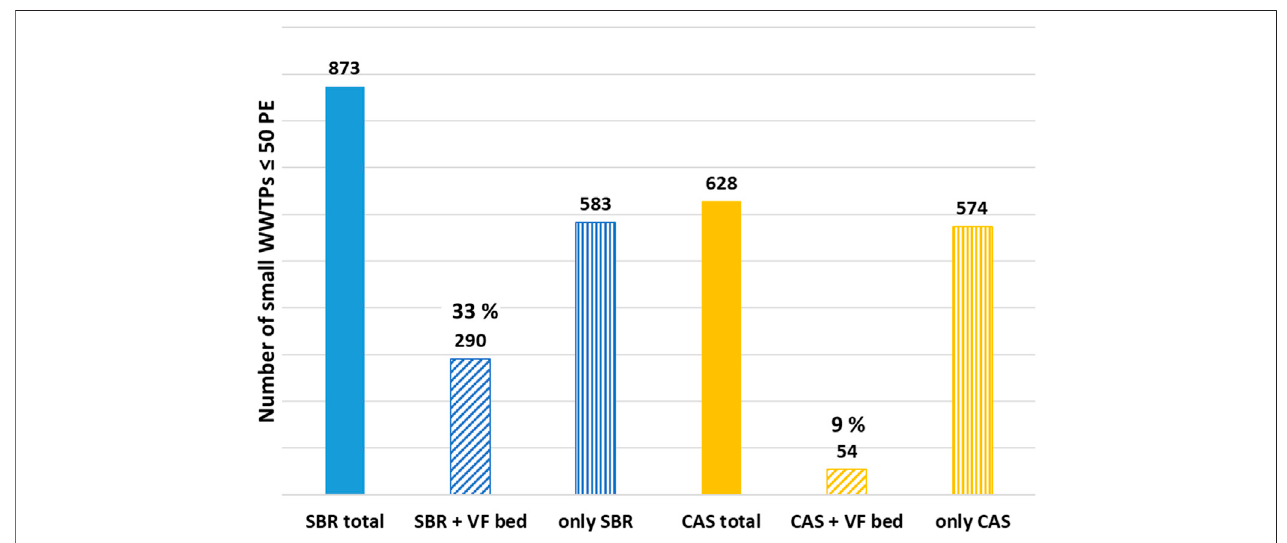
FIGURE 2 | SBR and CAS plants with/without a VF bed for polishing (adapted from Engstler, 2020).